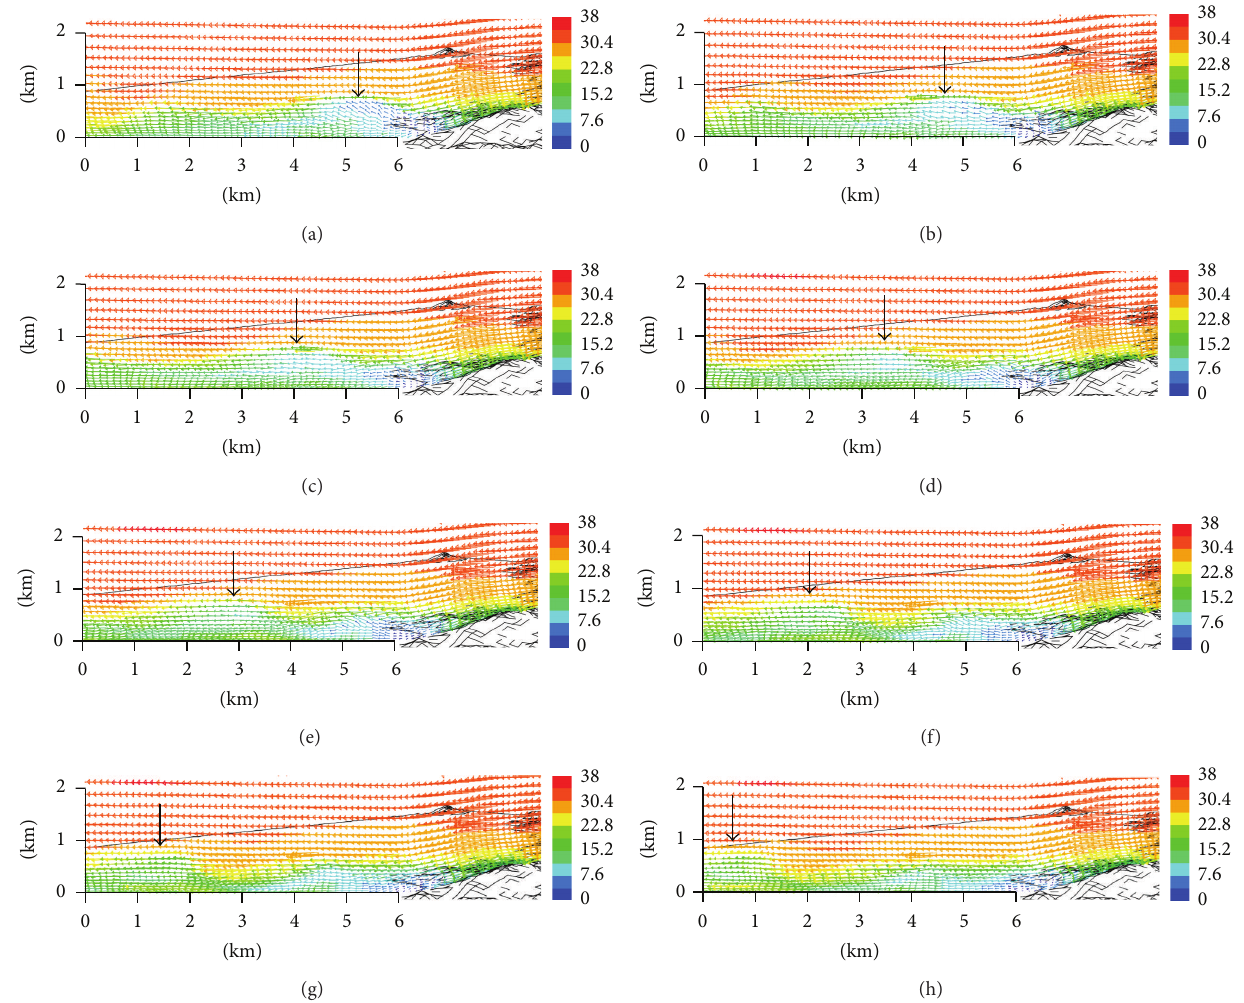
Figure 7: The wind vector projected on the vertical cross sectional planes. The wave shedding is highlighted in a black arrow (unit: m/s, time for each figure is same as that in Figure 5).